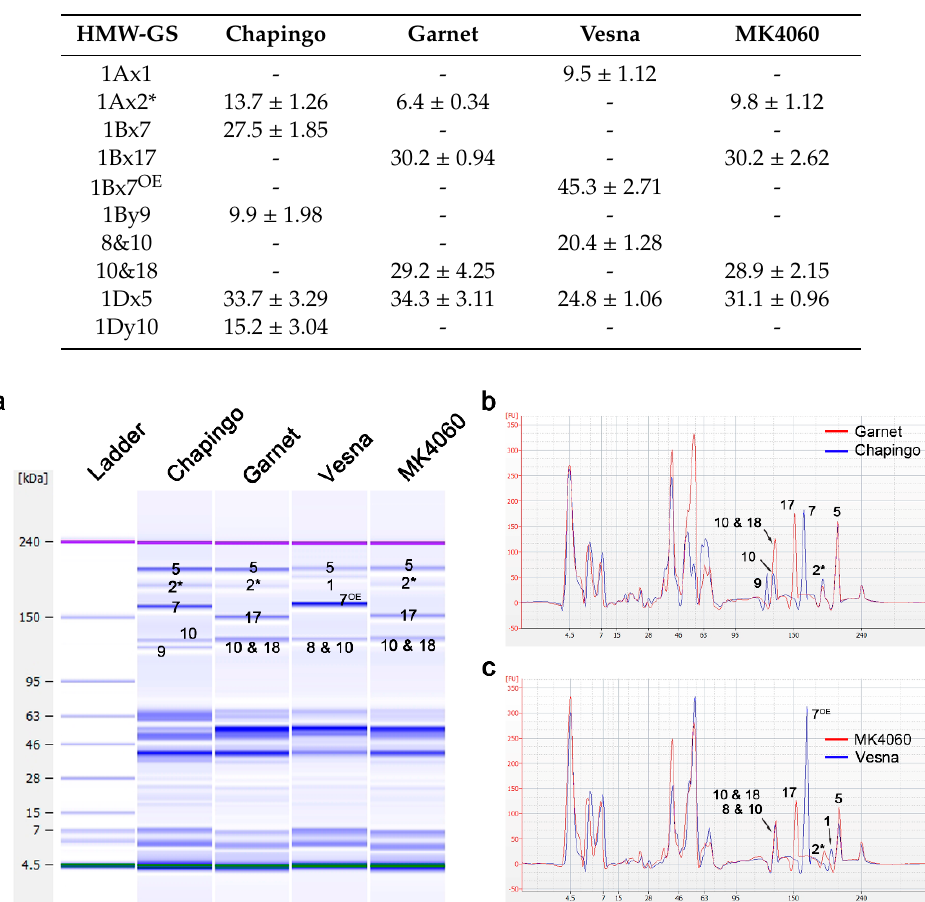
Table 3. Relative protein quantity of HMW-GS for 10 & 18 identification by Lab-on-a-chip. The relative protein quantity of each HMW-GS was analyzed by the band peak area on the electropherogram. Three independent experiments were performed. Values are the mean (%) ± SD.